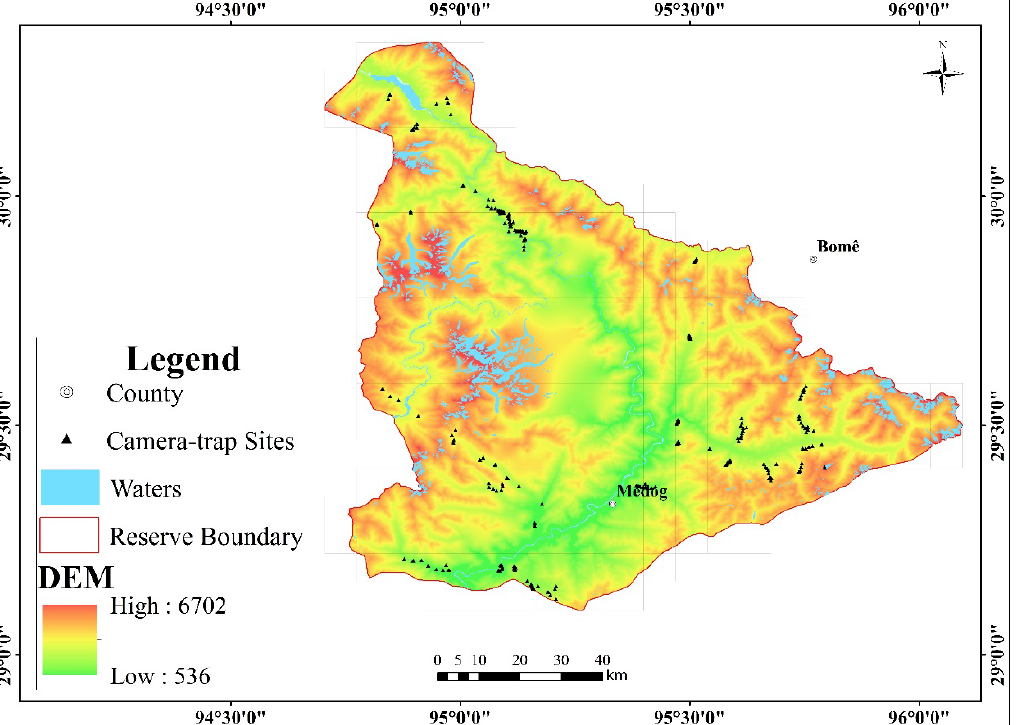
Table 1. Camera trap efforts and number of independent photographs of Muntiacus in the 11 survey areas in the Yarlung Zangbo Grand Canyon National Nature Reserve, Tibet, from 2013 to 2021.